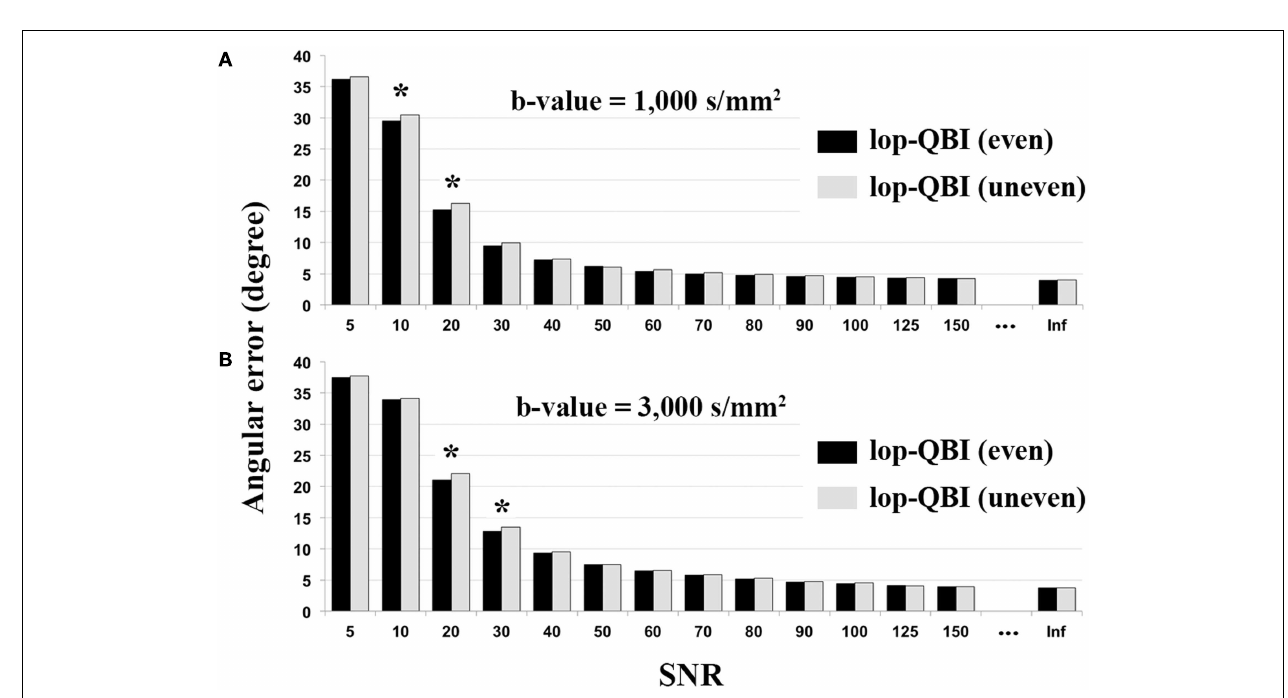
(A) is the results from simulation with b -value = 1,000s/mm 2 and (B) with b -value = 3,000s/mm 2 . Asterisks show statistically significant difference in mean values ( p <